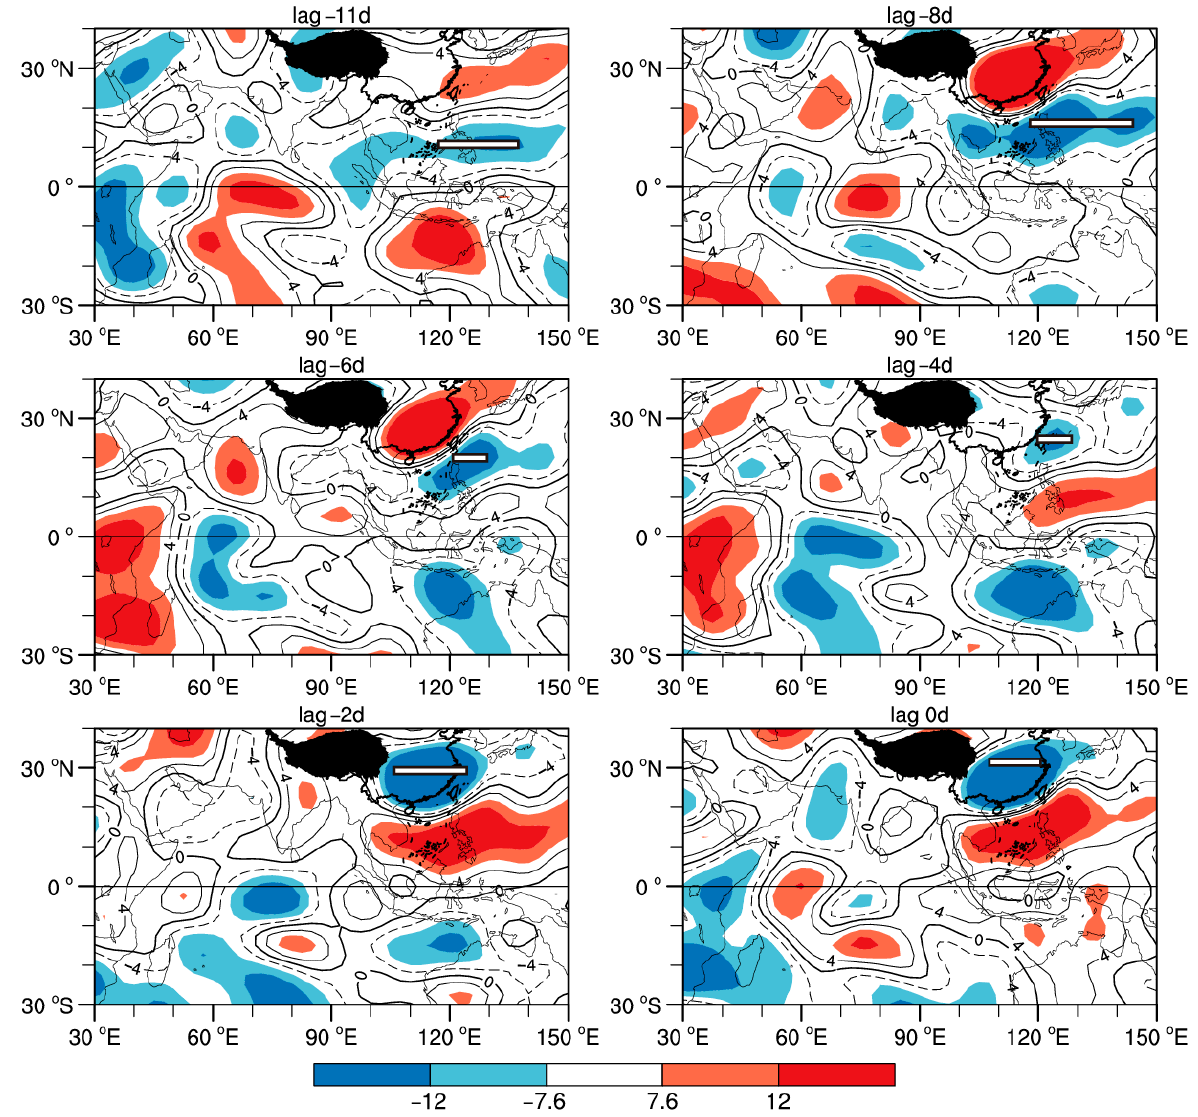
Figure 9. Same as Figure 8, but in drought years.